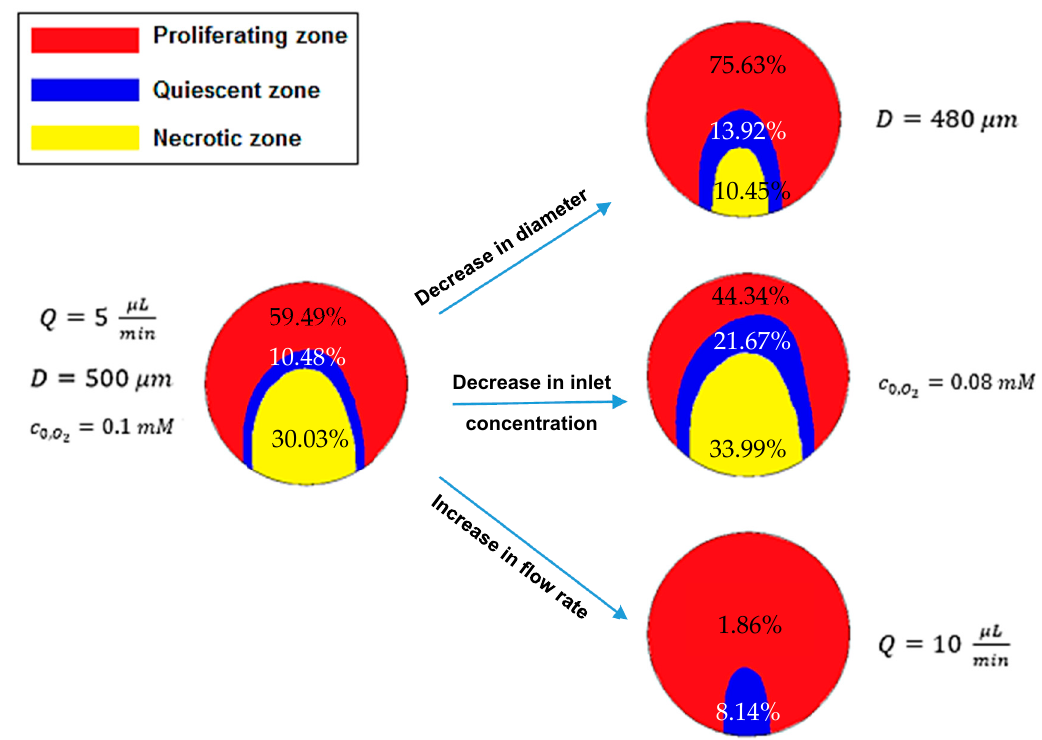
Figure 8. The effects of the diameter D , the inlet concentration of oxygen c 0, O the proliferating, quiescent and necrotic zones (red, blue and yellow, respectively) in the middle x – z plane of the spheroid based on oxygen concentration distribution. (The percentage of each region area to the total area of that cross section is reported on that region).